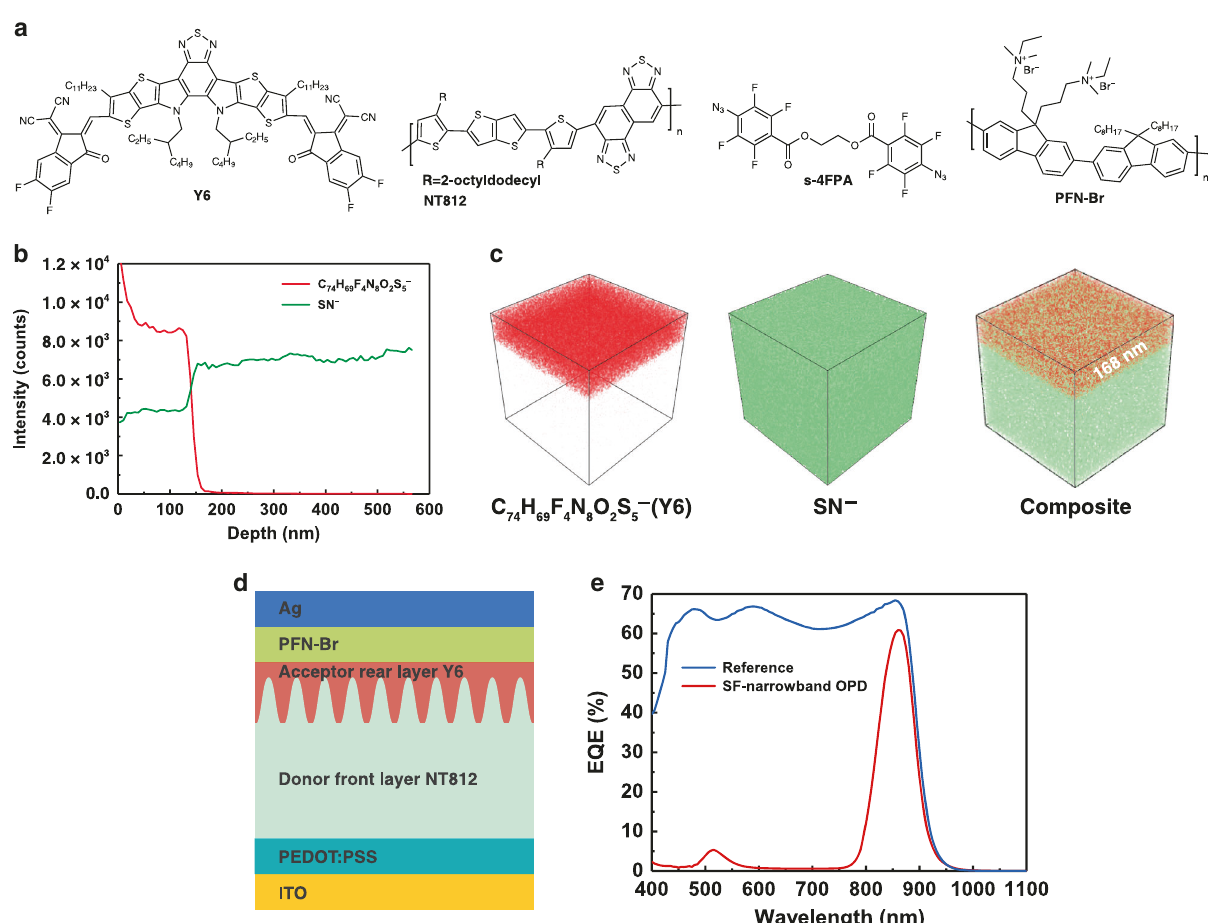
Fig. 1 Hierarchical structure and EQE response of OPDs. a Chemical structures of Y6, NT812, s-4FPA and PFN-Br. b Time-of- fl ight secondary ion mass spectrometry (ToF-SIMS) depth pro fi le through the prepared fi lm. c Reconstructed three-dimensional negative ion images (100 μ m × 100 μ m area) of C 74 H 69 F 4 N 8 O 2 S 5 − , SN − and their composite from a depth pro fi le of the prepared fi lm. d Basic device structure of self- fi ltering (SF) narrowband organic photodetector (OPD). e External quantum ef fi ciency (EQE) curves of the SF-narrowband OPD and reference device under − 0.1 V Figure 1e presents the EQE spectrum of the fabricated photodetector under − 0.1 V bias, which exhibits a dominant narrow peak at 860 nm accompanied by a weak response at 520 nm. Figure 1e also gives the EQE spectrum of the reference device with a conventional structure (ITO/PEDOT:PSS/NT812: Y6 (150 nm)/PFN-Br/Ag). EQE curves of the SF-narrowband OPD and the reference device show that, as the corresponding EQE response in visible spectrum is effectively suppressed in SF- narrowband OPD, the peak EQE at 860 nm is not signi fi cantly reduced, maintaining more than 89% of the corresponding value of reference device. By comparison, the BHJ device 11 with device struture of ITO/PEDOT:PSS/NT812:Y6 (800 nm, 1:4)/PFN-Br/ Ag suffers tremendous EQE loss, only obtains a peak EQE around 10% (as demonstrated in Supplementary Fig. 3).